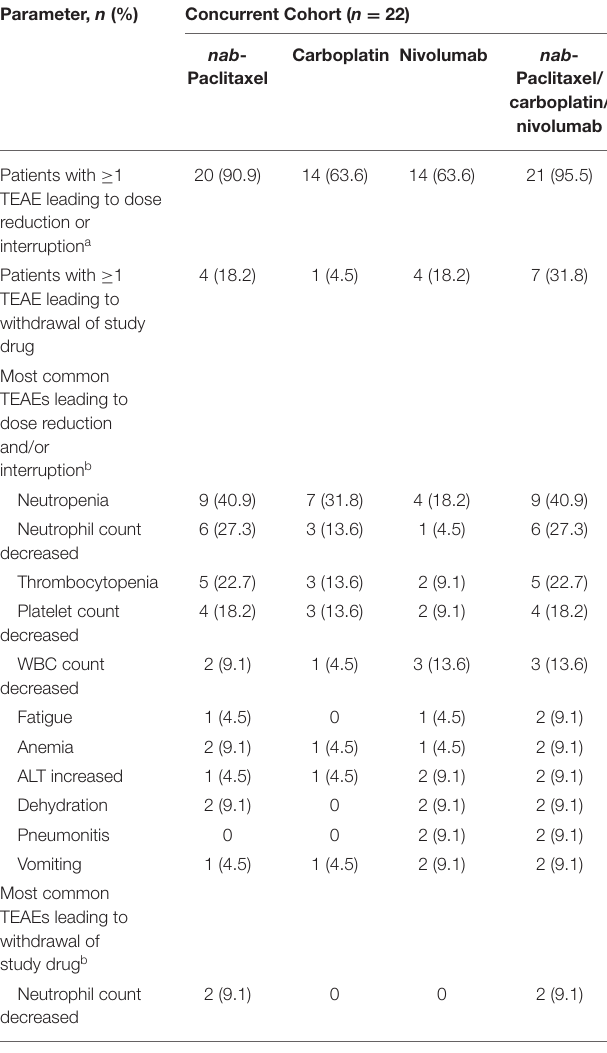
Table 3b | TEAEs leading to dose reduction, interruption, or discontinuation in the delayed nivolumab cohort. Parameter, n